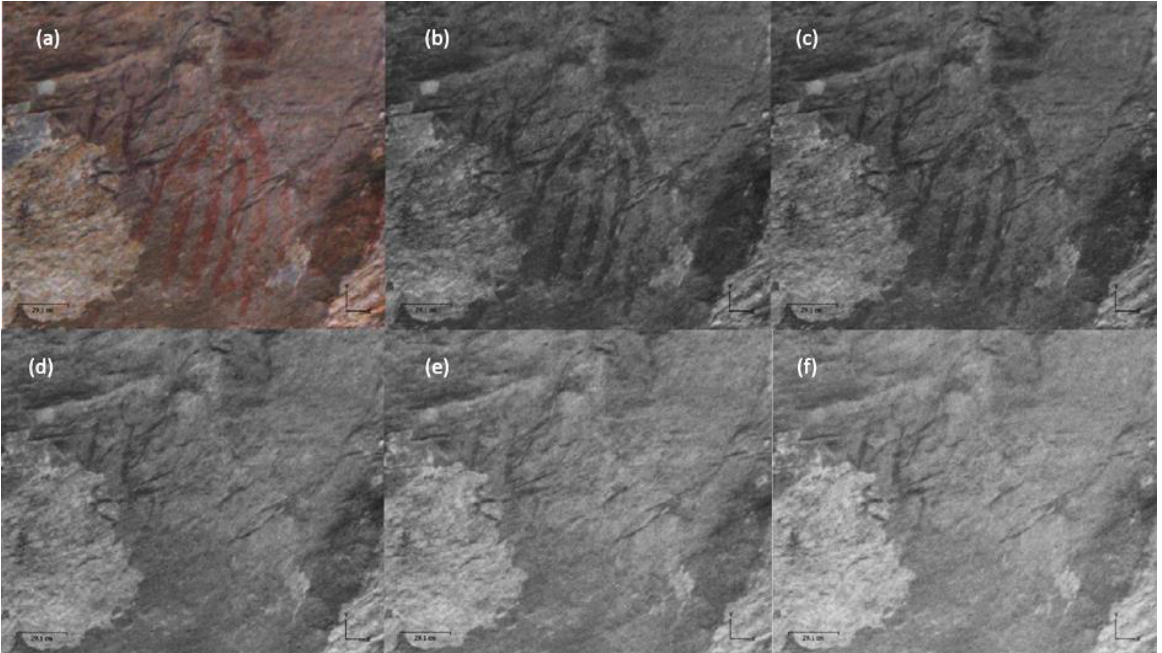
Figure 7: Close view on selected painting based on generated multiband orthophotos: (a)RGB, (b) Blue - 475nm, (c) Green - 560nm, (d) Red - 668nm, (e) Red-Edge - 717nm and (f) NIR -